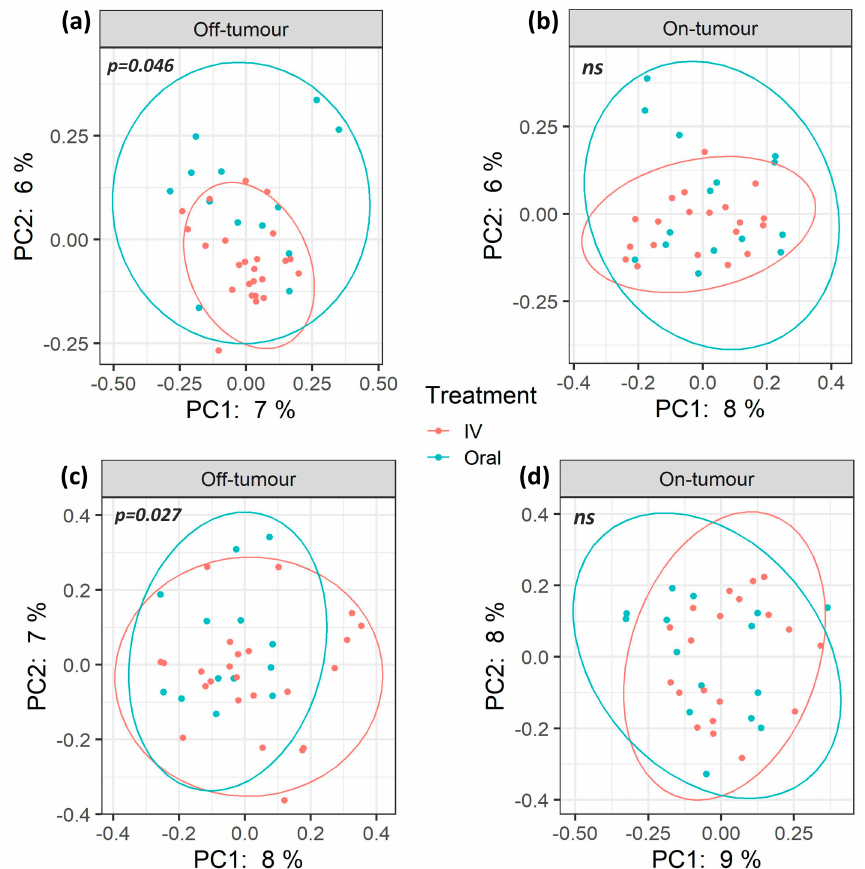
Figure 2. β -diversity of oral and intravenous iron-treated patients differs between on- and off-tumor microbiota. Principle coordinate analysis (PCoA) plots based on Jaccard ( a , b ) and Bray–Curtis ( c , d ) distances. Plot ellipses represent 95% confidence incidence for group clusters. The off-tumor β -diversity shows significantly distinct bacterial community clusters between oral and intravenous (IV) iron treatments ( a ; p = 0.046, c ; p = 0.027. On-tumour β -diversity shows no significant differences ( ns ) between iron treatment ( b , d